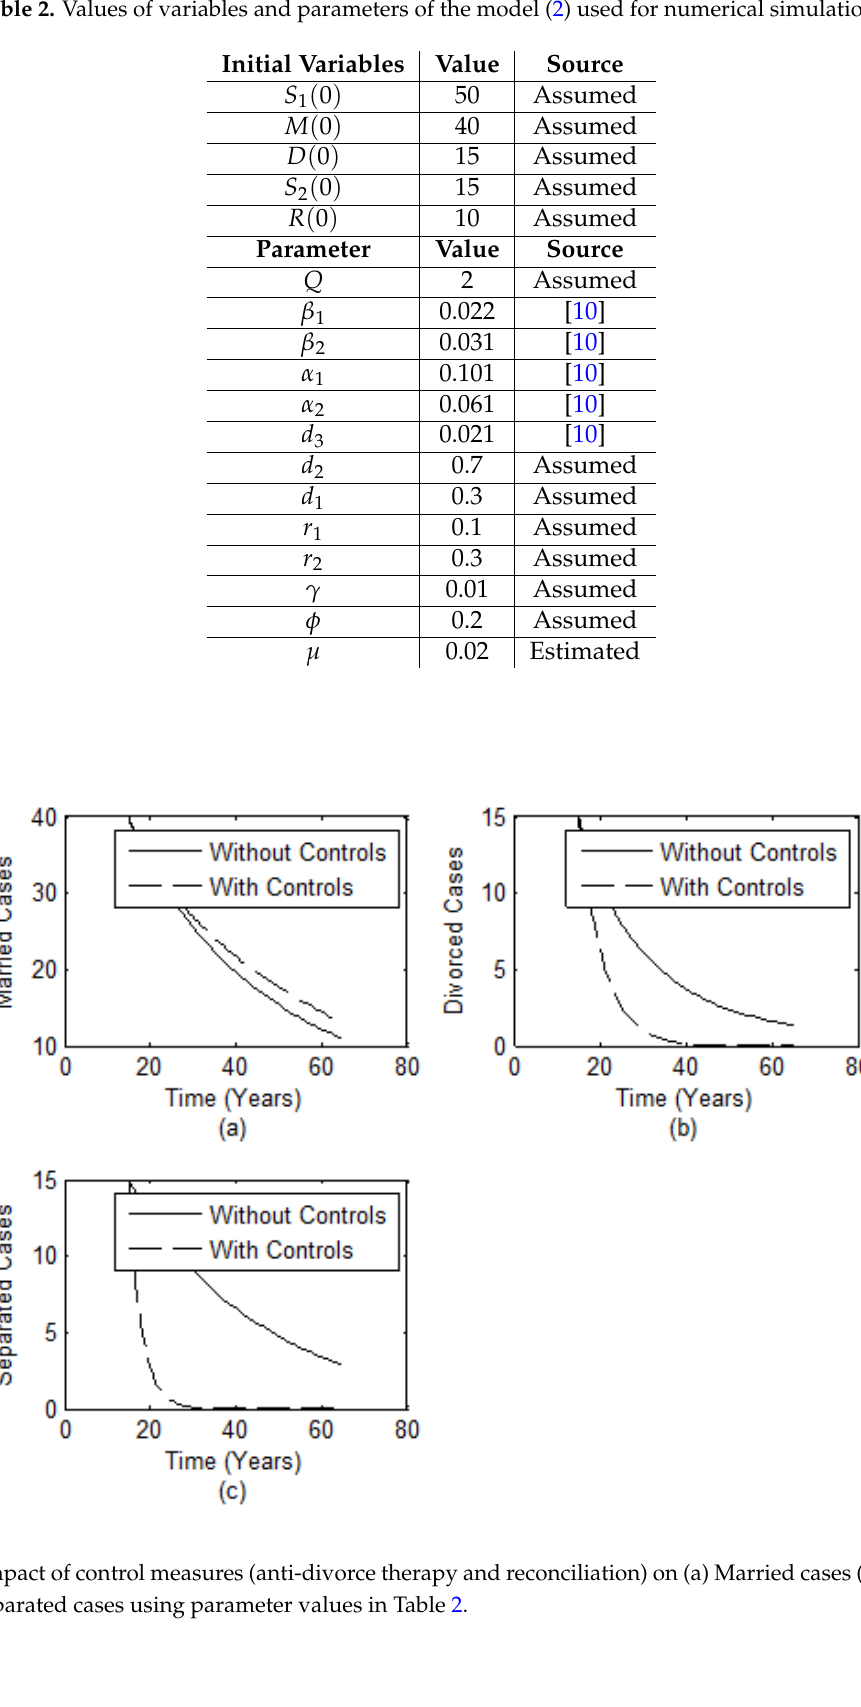
Table 2. Values of variables and parameters of the model (2) used for numerical simulations